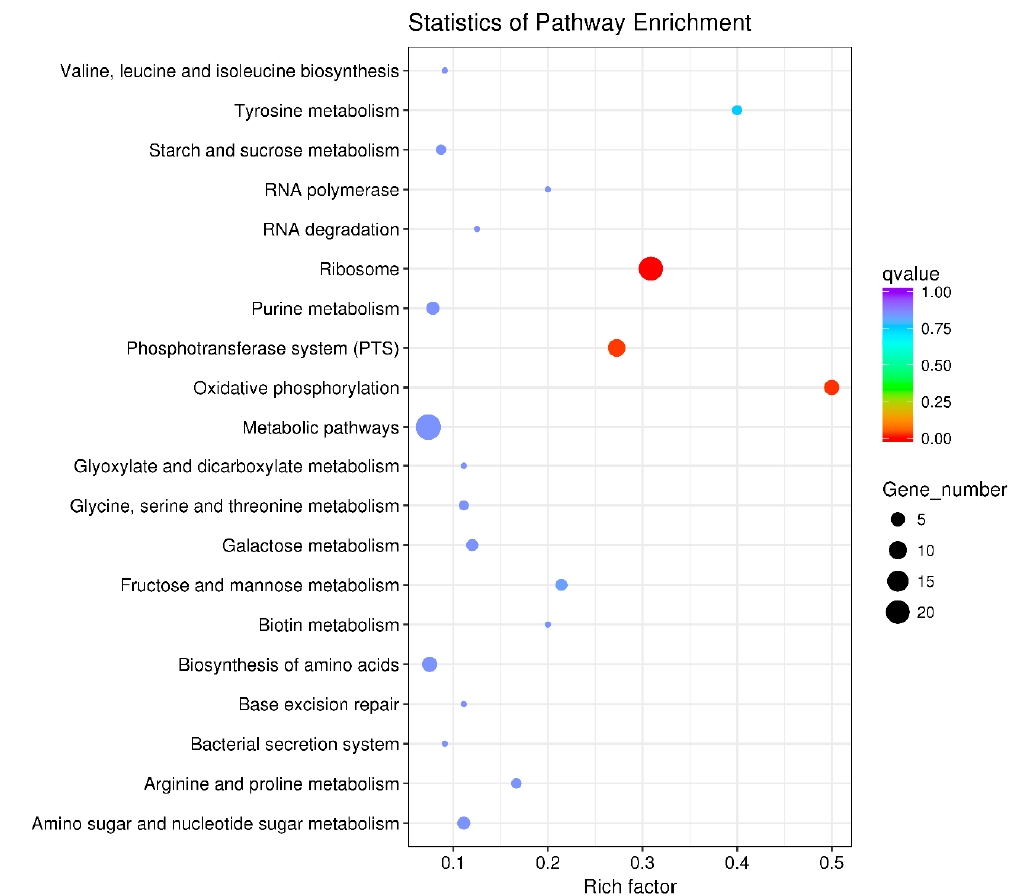
Figure 7. The top 20 KEGG pathways of the DEGs in response to cobalt toxicity. The size of the dot indicates the number of the DEGs enriched in the pathway, and the color indicates the q value. Rich factor was defined as the ratio of the number of the DEGs enriched in the pathway to the number of all genes annotated to this pathway. q value is the corrected p -value ranging from 0 to 1, and the lower the q value, the greater the pathway enrichment. KEGG pathway enrichment analysis was performed using the KOBAS 2.0 software with the hyper-geometric test. The KEGG pathways with a q value < 0.05 were considered to be significantly enriched.